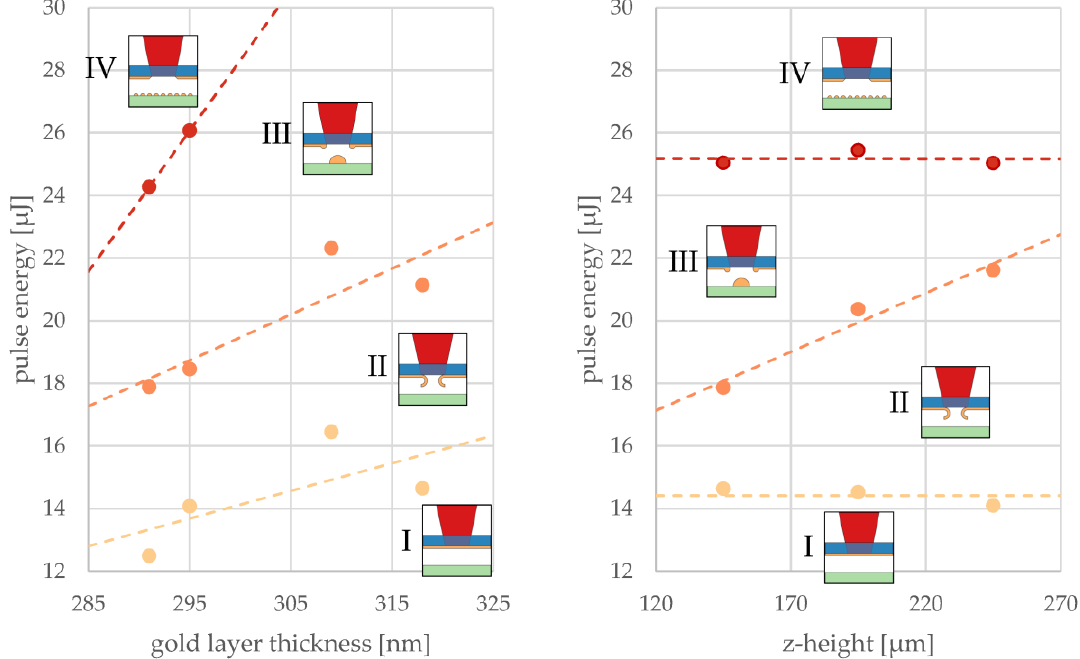
Figure 6. Influence of the layer thickness ( left ) and gap distance in the z-direction ( right ) on the minimum pulse energy marking the transition between the LIFT printing regimes I – IV introduced in Figure 5. Each data point represents the pulse energy minimum averaged over the z-heights ( left ) for one layer thickness or averaged over different layer thicknesses for one z-height ( right ). Straight lines serve as a guide for the eye to distinguish between the different regimes.